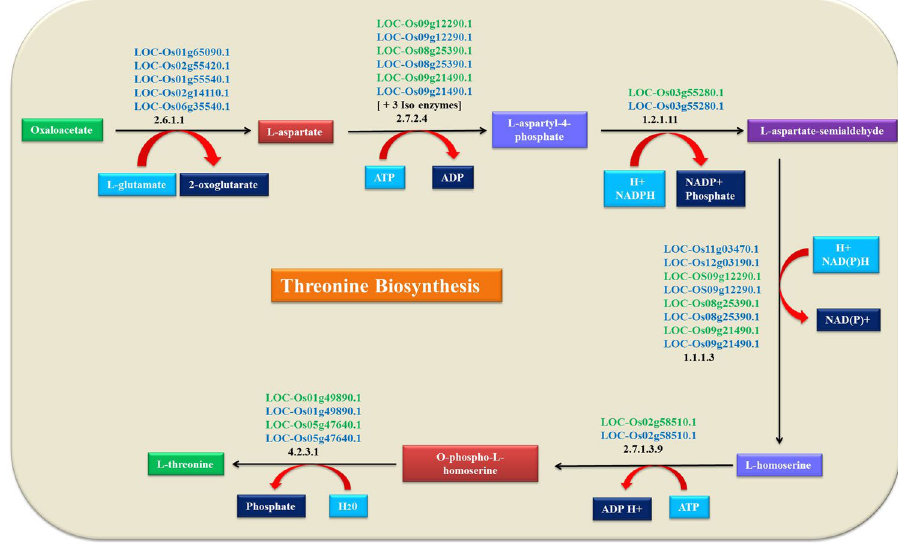
Figure 1. Threonine biosynthesis